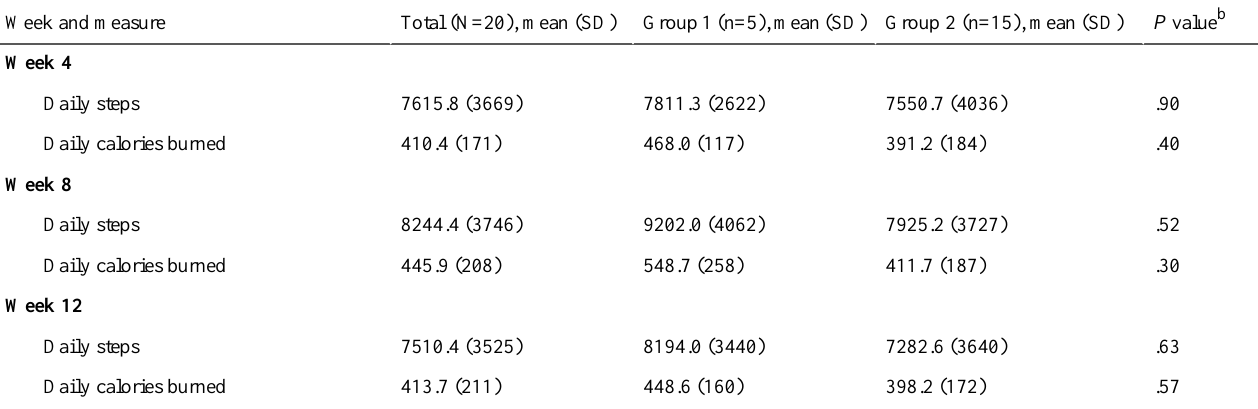
Table 2. The daily mean number of steps walked and estimated calories burned (N=20) for groups 1 and 2 a .